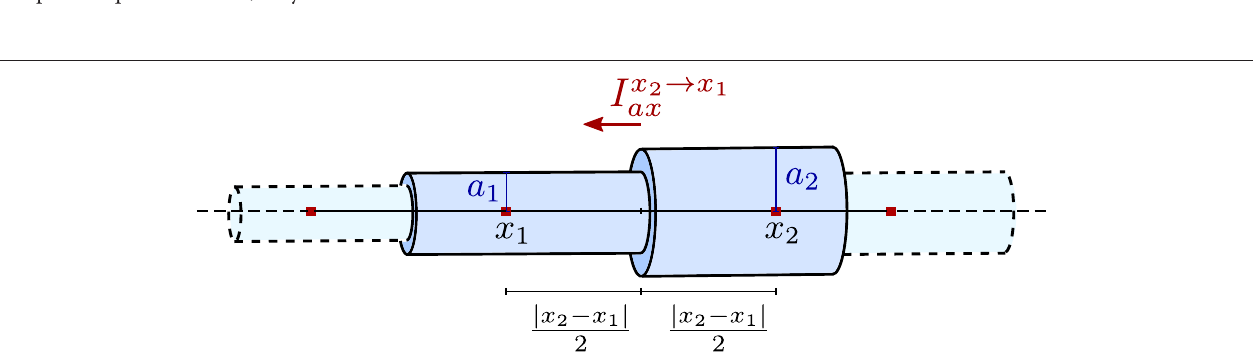
FIGURE 3 | Illustration of the piece-wise tubular compartments of the Finite Volume cable equation model and the definition of axial ohmic flux.